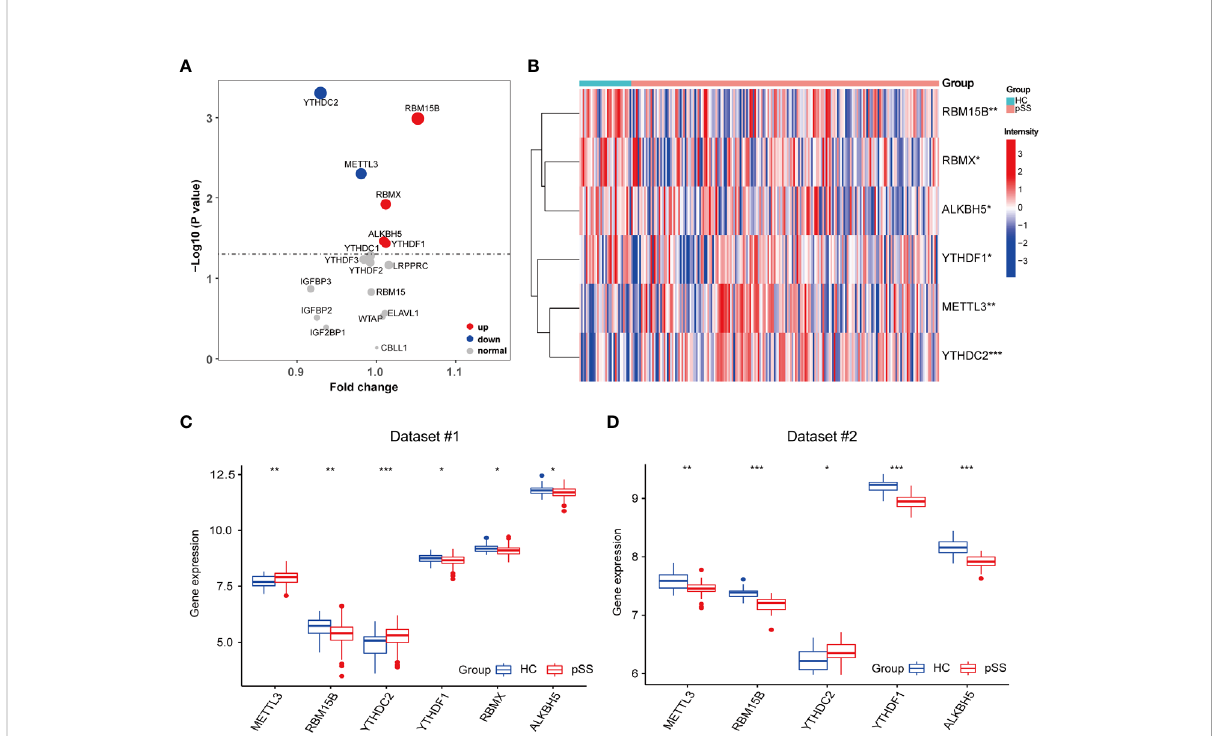
FIGURE 2 Identi fi cation of pSS-related m6A regulators. (A) The volcano plot illustrates the m6A regulators that are dysregulated between the HCs and pSS groups. Upregulated and downregulated signi fi cant genes (p < 0.05) are indicated in red and blue dots, respectively. B-D. The heatmap (B) and the box plots (C, D) demonstrated the transcriptome expression status of the 6 DEMRs between healthy and pSS PB samples in dataset #1 (B, C) and dataset #2 (D) . *, p<0.05; **, p<0.01; ***,